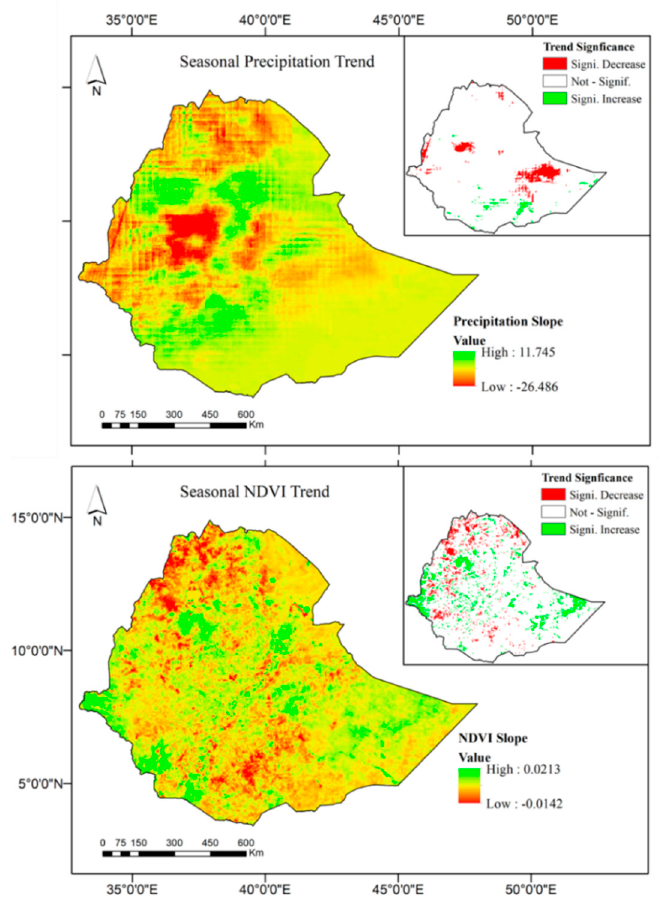
Figure 6. Spatial and temporal trends of seasonal precipitation, and NDVI in Ethiopia from 2001 to 2018. Positive slope values indicate an increasing monotonic trend, while negative slope values indicate a decreasing monotonic trend.